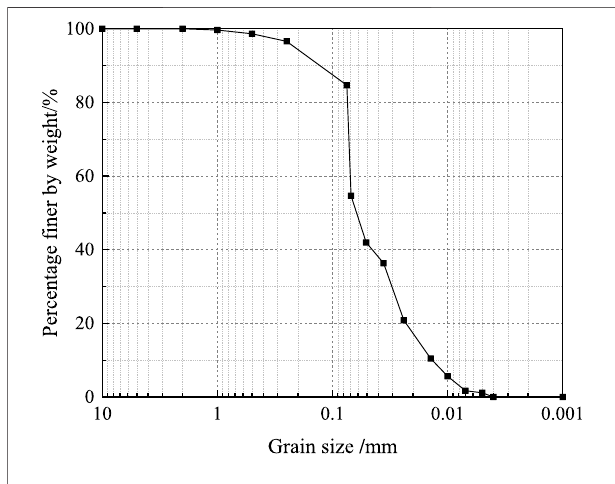
FIGURE 1 | Grain size